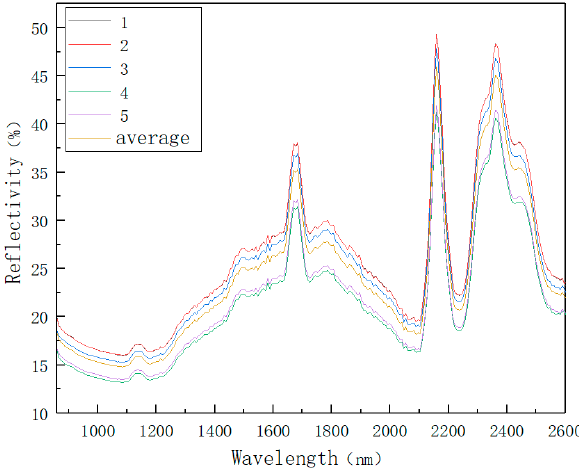
Figure 4. Five-point sampling spectrum of the sample. The mean of the spectral data of the five points represents the soil sample spectrum data. Normalizing the procedure as described above and changing the background spec- trum every hour. Some obviously problematic data points were eliminated by preset conditions. The spectral data of 143 soil samples were collected by setting the parameters of the experimental instrument and controlling the collection environment. The spectral data are shown in Figure 5.